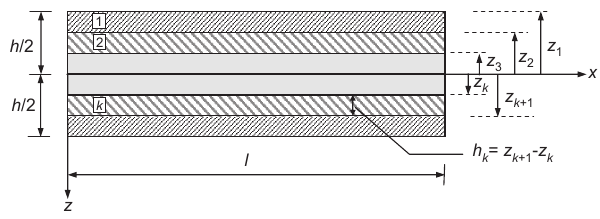
Figure 1 Coordinate system and layer numbering used for a lami- nated composite